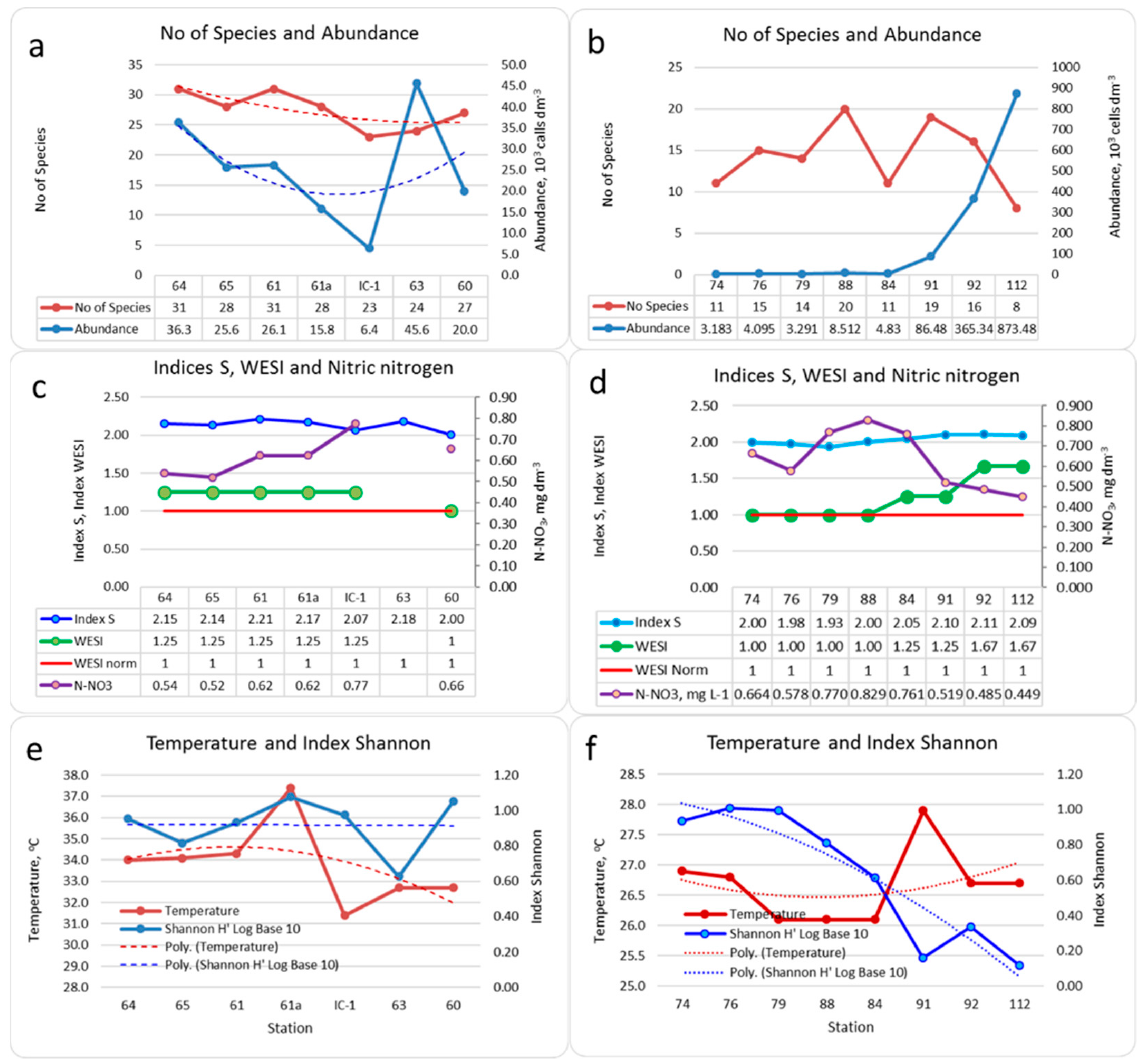
Figure 9. Dynamics of the main biological and chemical variables at the stations of the Tashlyk ( a , c , e ) and Alexandrovskoye ( b , d , f ) reservoirs. Stations are placed in order to the reservoir axis from upstream to downstream .